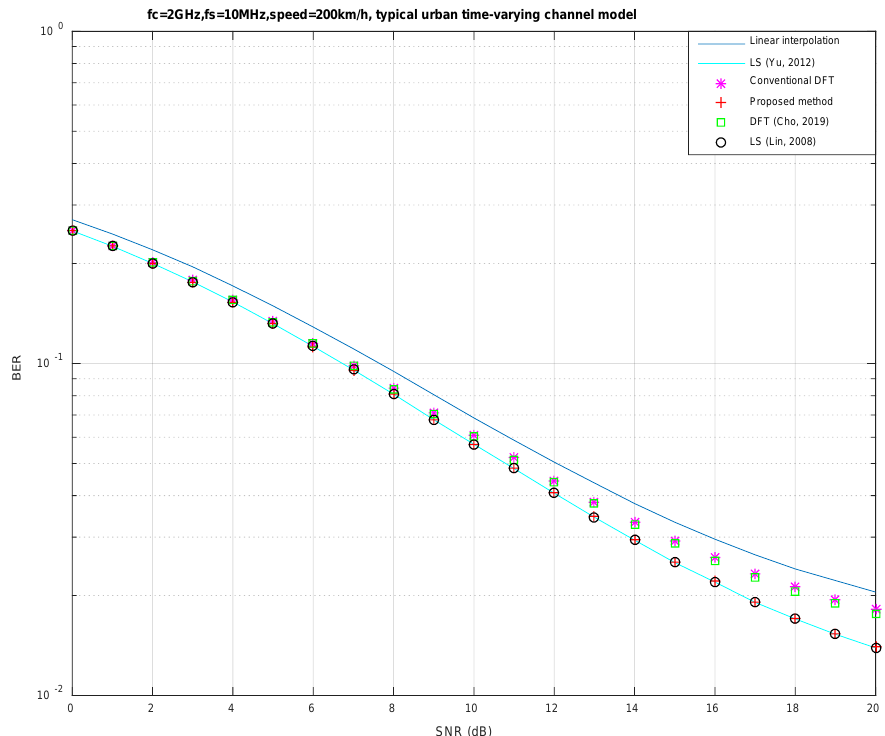
Figure 4. Simulated diagram of SNR to error rate when the carrier frequency is 2 GHz, the sampling frequency is 10 MHz, and the speed is 200 km/h for the typical urban time-varying channel model [8,10,11]. Table 5. Comparisons of different methods on computational complexity and memory resource us- age. Method